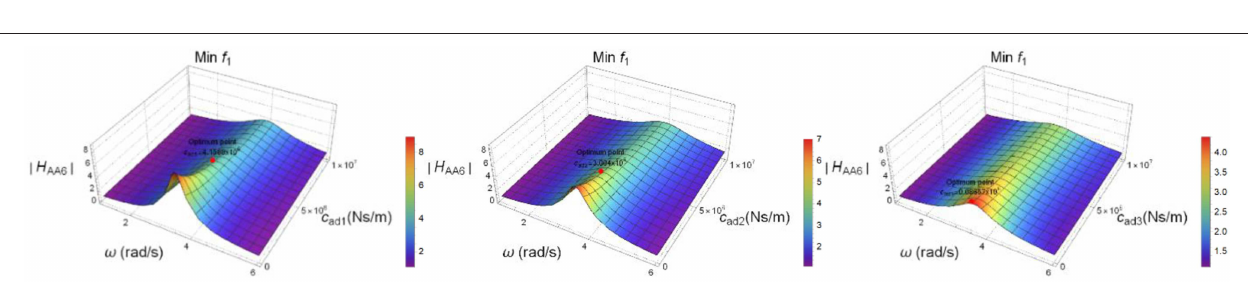
FIGURE 8 | 3D plots of the absolute value of transfer function